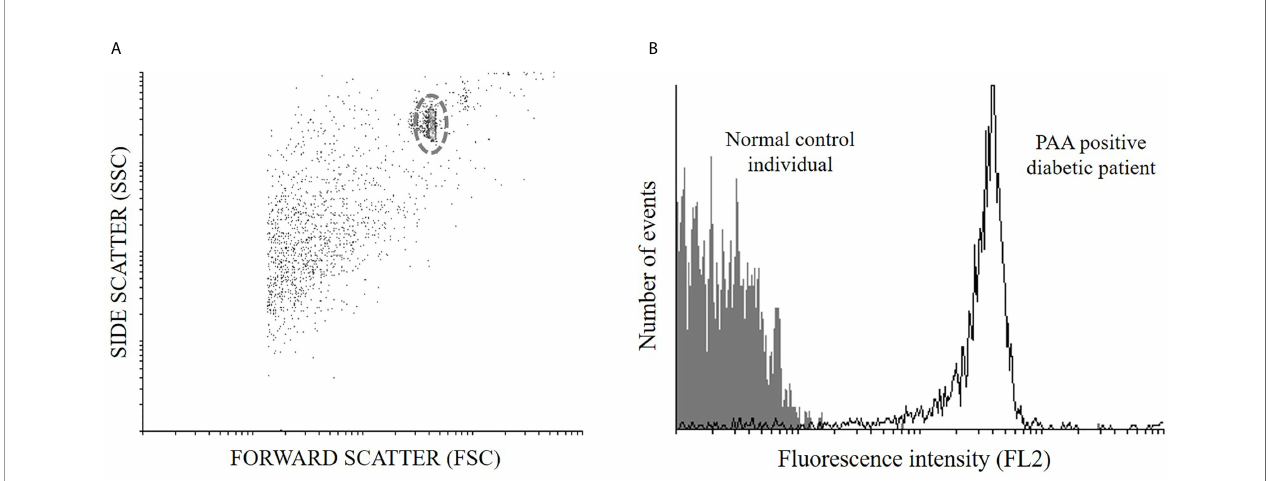
FIGURE 1 | Signal processing. (A) Population of 5 m m microspheres adsorbed with TrxPI observed in a Dot plot graph of side scatter (SSC) vs. forward scatter (FSC) for purposes of gating (B) Histogram of number of events vs. Fluorescence intensity (FL2 channel) to measure the fl uorescence associated with each sample; representative signals are shown for the sera from a normal control individual and a PAA positive diabetic